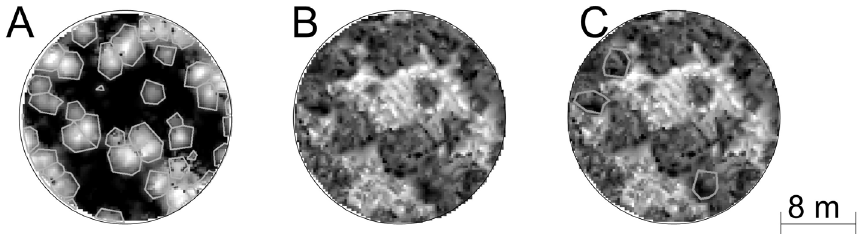
Figure 4. Tree crowns delineated and classified for the field plot #124: ( A ) Individual tree crowns delineated from the canopy height model. ( B ) Canopy intensity model of first returns (above 2 m). ( C ) Individual tree crowns classified as dead. Low height/intensity values are depicted in dark tones and high height/intensity values in light tones.